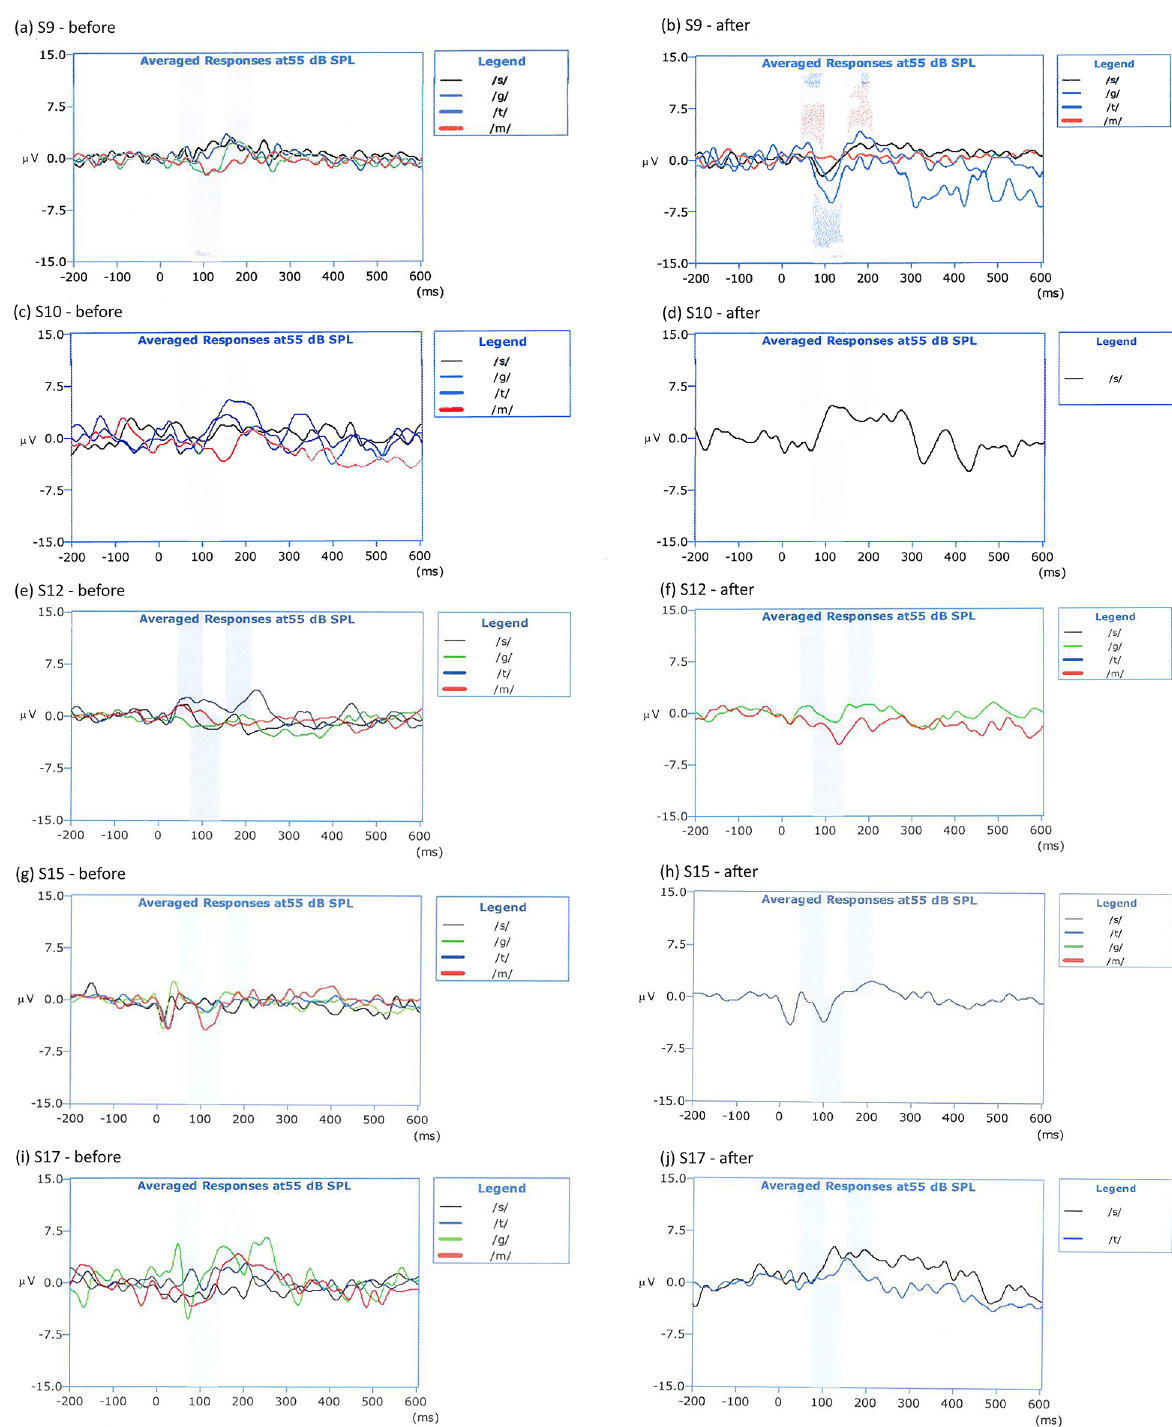
Fig 2. Before and after CAEP traces for the 5 subjects (#s 9, 10, 12, 15, 17) whose fitting maps had to be adjusted.